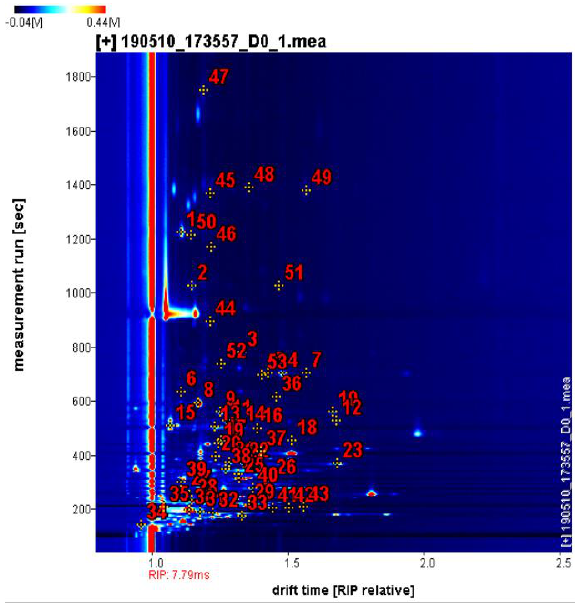
Figure 1. Ion migration spectra of jujube fruits stored for different times at 4 °C. The numbers are identified volatile components.